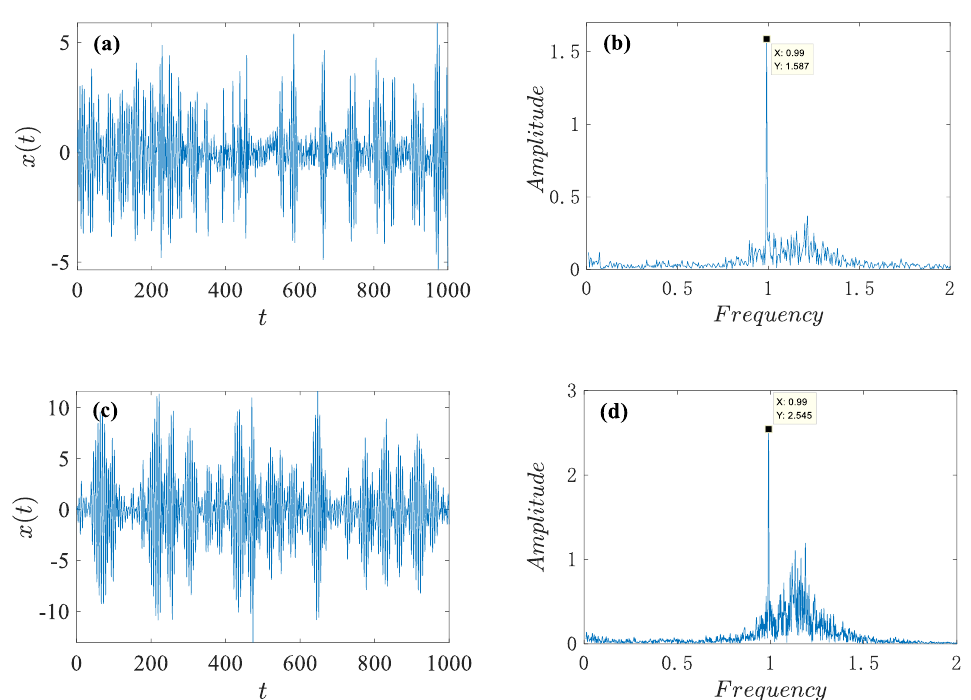
Figure 16. Simulation results of x ( t ) in terms of time and frequency domain for ( a , b ) ∆ 2 = 1, ( c , d ) ∆ 2 =